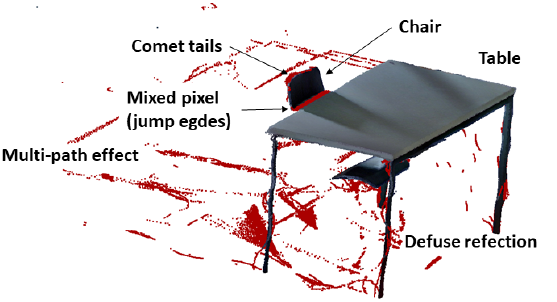
Figure 1. Examples of objects (chair and table) and scanning artifacts in a point cloud. Common scanning artifacts are: comet tails, mixed pixels on edges (jump edges), multi-path effects and defused